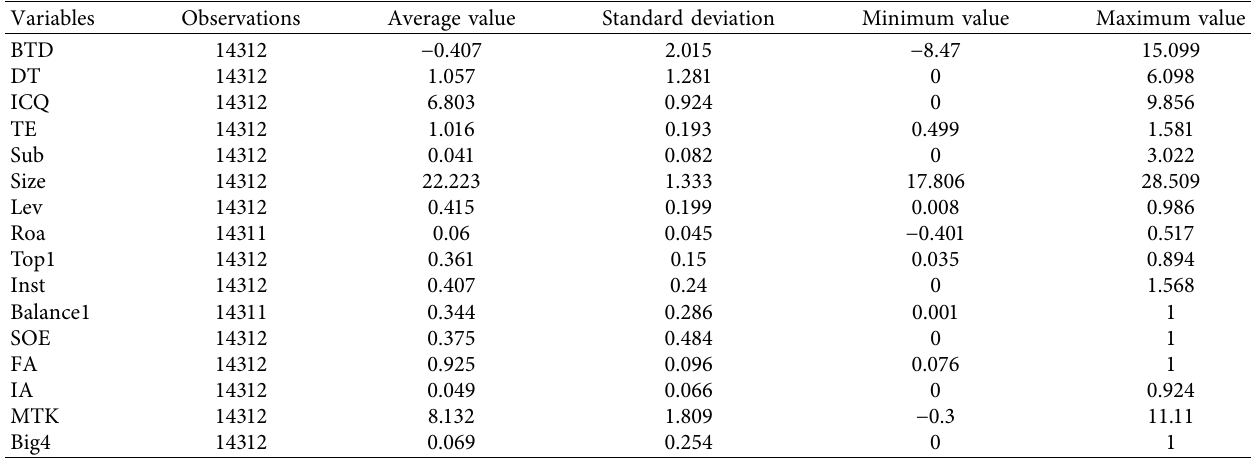
Table 2: Descriptive